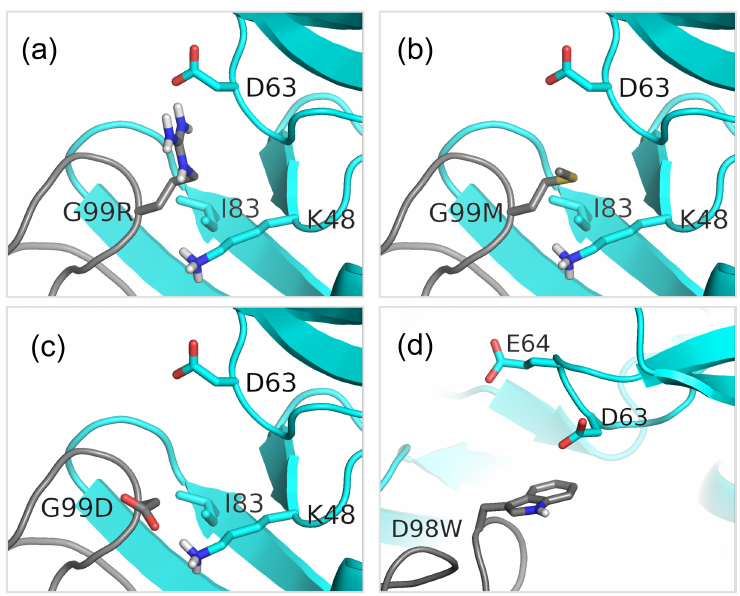
Fig 3. Structural basis for increased affinities of the HD98W and HG99X mutations for bH1-VEGF binding. The bH1 and VEGF chains are coloredgrey and cyan, respectively.(a) Modeledbindingmode of the HG99R. A salt bridgeis formed betweenHG99R of bH1 and D63 of VEGF. (b) Modeledbindingmode of HG99M. Nonpolarinteractionsare formed betweenHG99M of bH1 and I83 and K48 of VEGF. (c) Modeled bindingmode of the HG99D. A salt bridgeis formed betweenHG99D of bH1 and K48 of VEGF. (d) HD98W removes unfavorable electrostatic interactions of HD98with D63 and E64 of bH1.